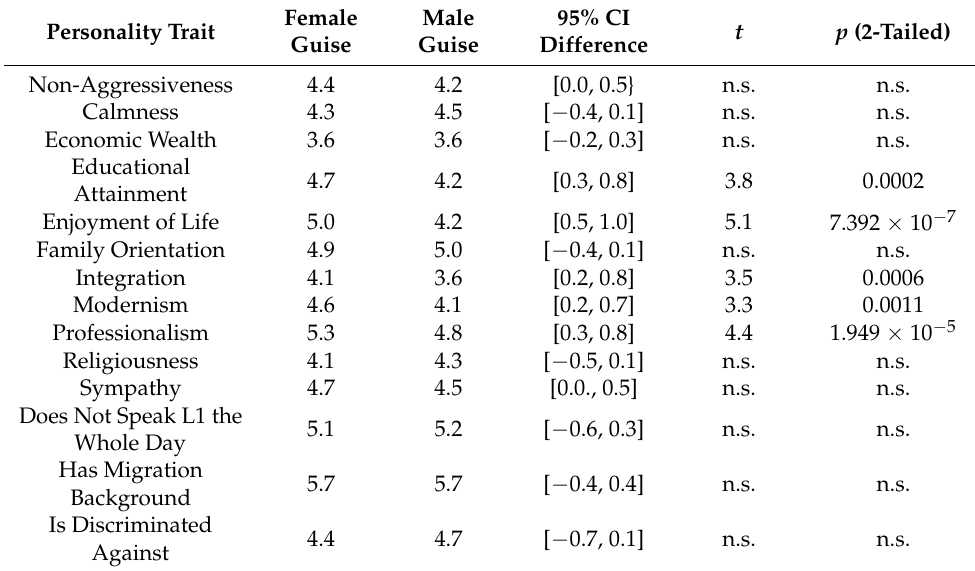
Table 5 shows differences in evaluation of the male and female Turkish guises. As in Table 4 above, the significance level was Bonferroni-corrected so that every p -value over 0.0035 was discarded as not significant. Table 5. Welch two-sample t -test by speaker gender—Turkish 1 . Personality